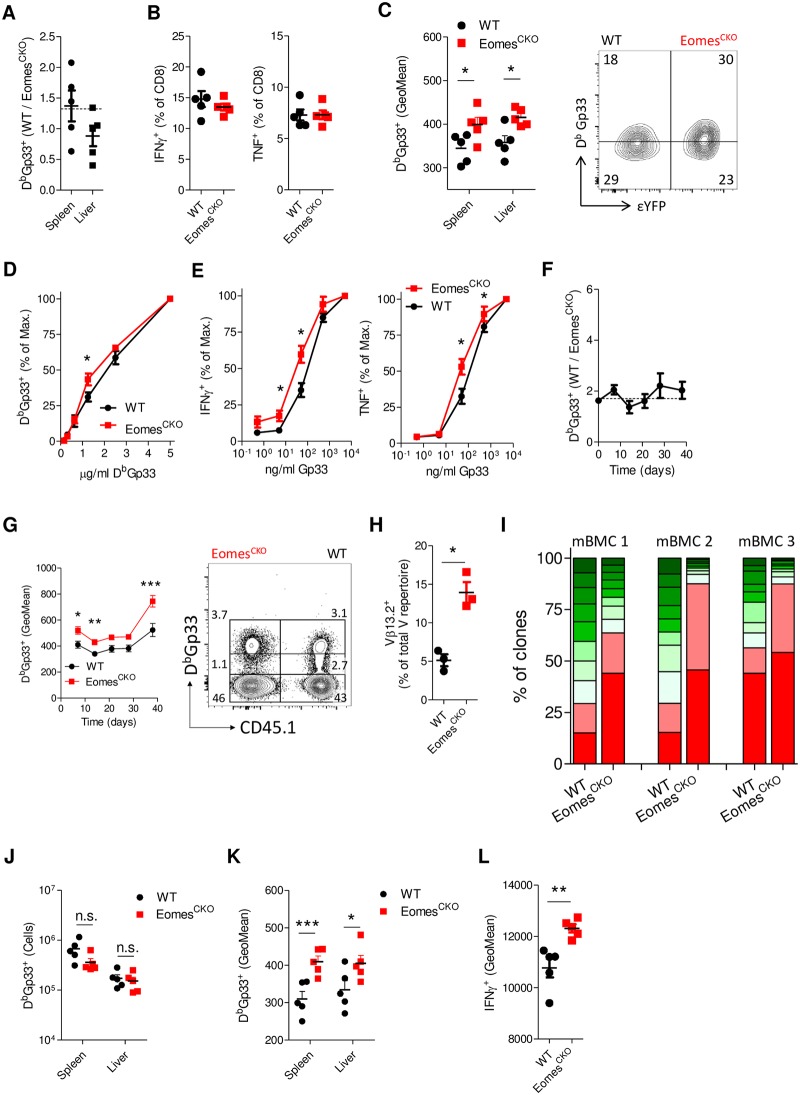
Eomes promotes the clonal diversity of the memory CD8 T-cell pool.mBMCs were infected with LCMV. (A-E) On day 7 after infection animals were analyzed. (A) Ratio between WT and EomesCKO DbGp33+ T cells in indicated organs. Dashed line indicates ratio between total donor WT and EomesCKO CD8 T cells at day 0. (B) Frequency of IFNγ+ and TNF+ cells upon in vitro restimulation of splenocytes with Gp33 peptides. (C) Quantification of the GeoMean of tetramer binding of WT and EomesCKO DbGp33+ CD8 T cells in spleen. Representative contour plot is gated for CD8+DbGp33+ donor cells. Arbitrary gates indicate low and high tetramer binding. (D) Splenocytes were stained with increasing amounts of DbGp33 tetramer. Percentage of tetramer+ cells relative to cells stained with 5 μg/ml is shown. (E) Splenocytes were stimulated in vitro with increasing amounts of Gp33 peptides. Percentage of IFNγ+ and TNF+ cells relative to cells stimulated with 5 μg/ml is shown. mBMCs were generated using WT (CD45.1+) and EomesCKO (CD45.2+EYFP+) cells in WT (CD45.2+) recipients. Reconstituted animals were infected with LCMV and at indicated time points cells were analyzed by flow cytometry. (F,G) Analysis of DbGp33+ WT and EomesCKO CD8 T cells in blood at indicated time points after infection. (F) Ratio between donor DbGp33+CD8+ WT and EomesCKO T cells over time. Dashed line indicates ratio between total donor WT and EomesCKO CD8 T cells at day 0. (G) Quantification of the GeoMean of DbGp33 binding of WT and EomesCKO tetramer+ CD8 T cells. Representative FACS plot shows cells at day 38 after infection. Gated is for CD8+ donor cells. Arbitrary gates indicate no, low, and high tetramer-binding CD8+ T cells. (H,I) Thirty days after infection, WT and EomesCKO CD8+DbGp33+ cells were sorted and analyzed by TCR sequencing. (H) Shown is the contribution of clones within the Vβ13.2+ family as a frequency of the total response. (I) Contribution of individual clones to the Vβ13.2 family. Each color represents one clone. (J-L) On day 41 after infection, mice were reinfected with LM-Gp33. After 5 days, antigen-specific responses were analyzed. (J) Number of DbGp33+ WT and EomesCKO CD8 T cells. (K) Quantification of the GeoMean of DbGp33 binding of tetramer+ CD8 T cells. (L) Splenocytes were stimulated in vitro with Gp33 peptides and cytokine production was determined by FACS. Student t test was used to analyze differences between groups. Shown are representative plots of at least two experiments using 3–6 mice per group. Shown are means ± s.e.m. *P < 0.05, ***P < 0.001. Values for each data point can be found in S1 Data. EomesCKO, Eomesflox/flox CD4Cre; FACS, fluorescence-activated cell sorting; GeoMean; geometric mean; Gp33, KAVYNFATC; IFNγ, interferon gamma; LCMV, lymphocytic choriomeningitis virus; LM, L. monocytogenes; mBMC, mixed bone marrow chimera; n.s., not significant; TCR, T-cell receptor; TNF, tumor necrosis factor; WT, wild-type; YFP, yellow fluorescent protein.